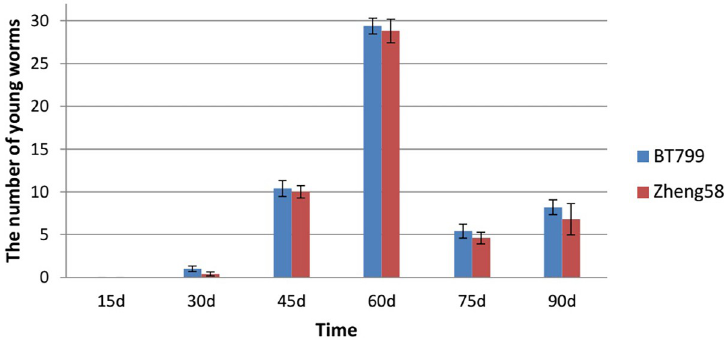
Fig 4. Effects of Bt maize on the number of young worms produced by E . fetida . Values are means ± SE, n = 5.